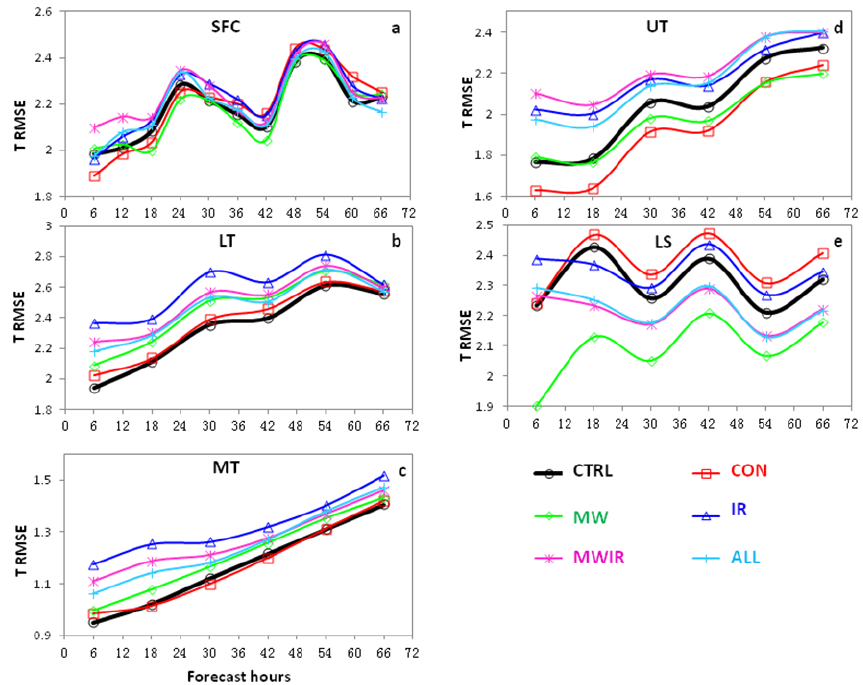
Figure 6. RMSE of the temperature ( T ) forecasts at (a) surface (SFC), (b) lower troposphere (LT), (c) middle troposphere (MT), (d) upper troposphere, (e) lower stratosphere. Unit: ◦ C. Other definitions can be found in Table 1.